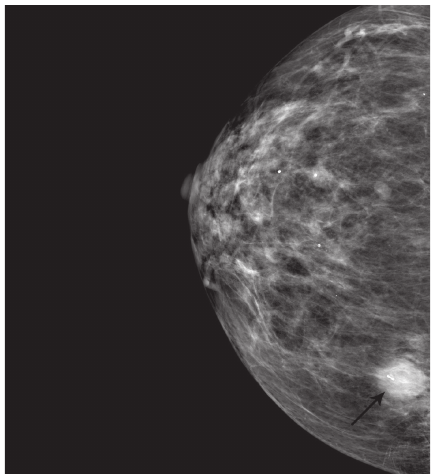
Figure 2: Mammographic image of the breast showing highly vascular spiculated hypoechoic mass measuring 1.35 cm × 1.46cm × 1.22 cm (arrow).